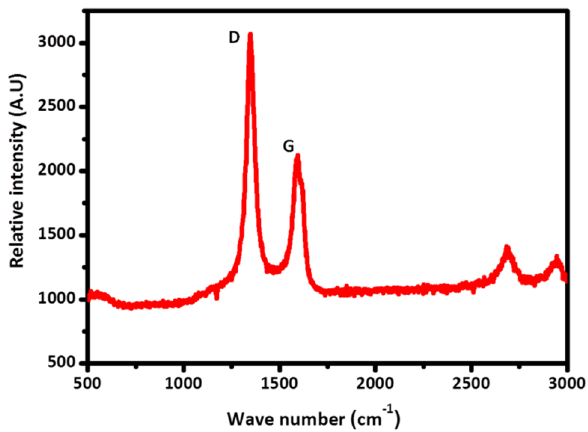
Figure 4. Raman spectrum for ~30–50 nm PECVD carbon grown on 70 nm TiN coated silicon substrate at 800 °C for 3 min.